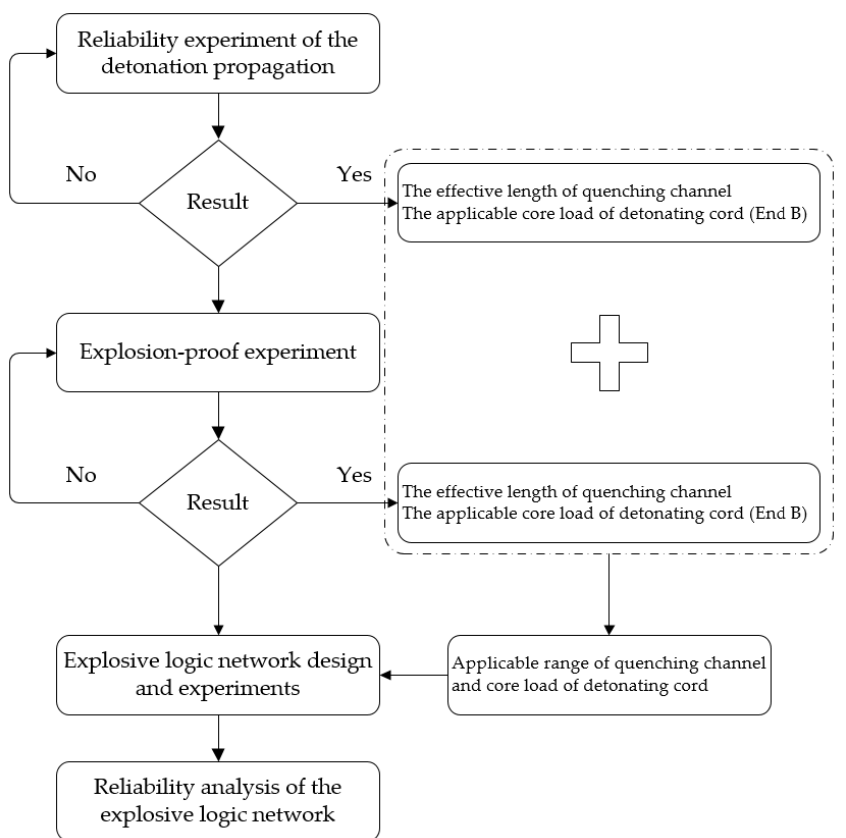
Figure 3. Flow diagram of the experimental methods.